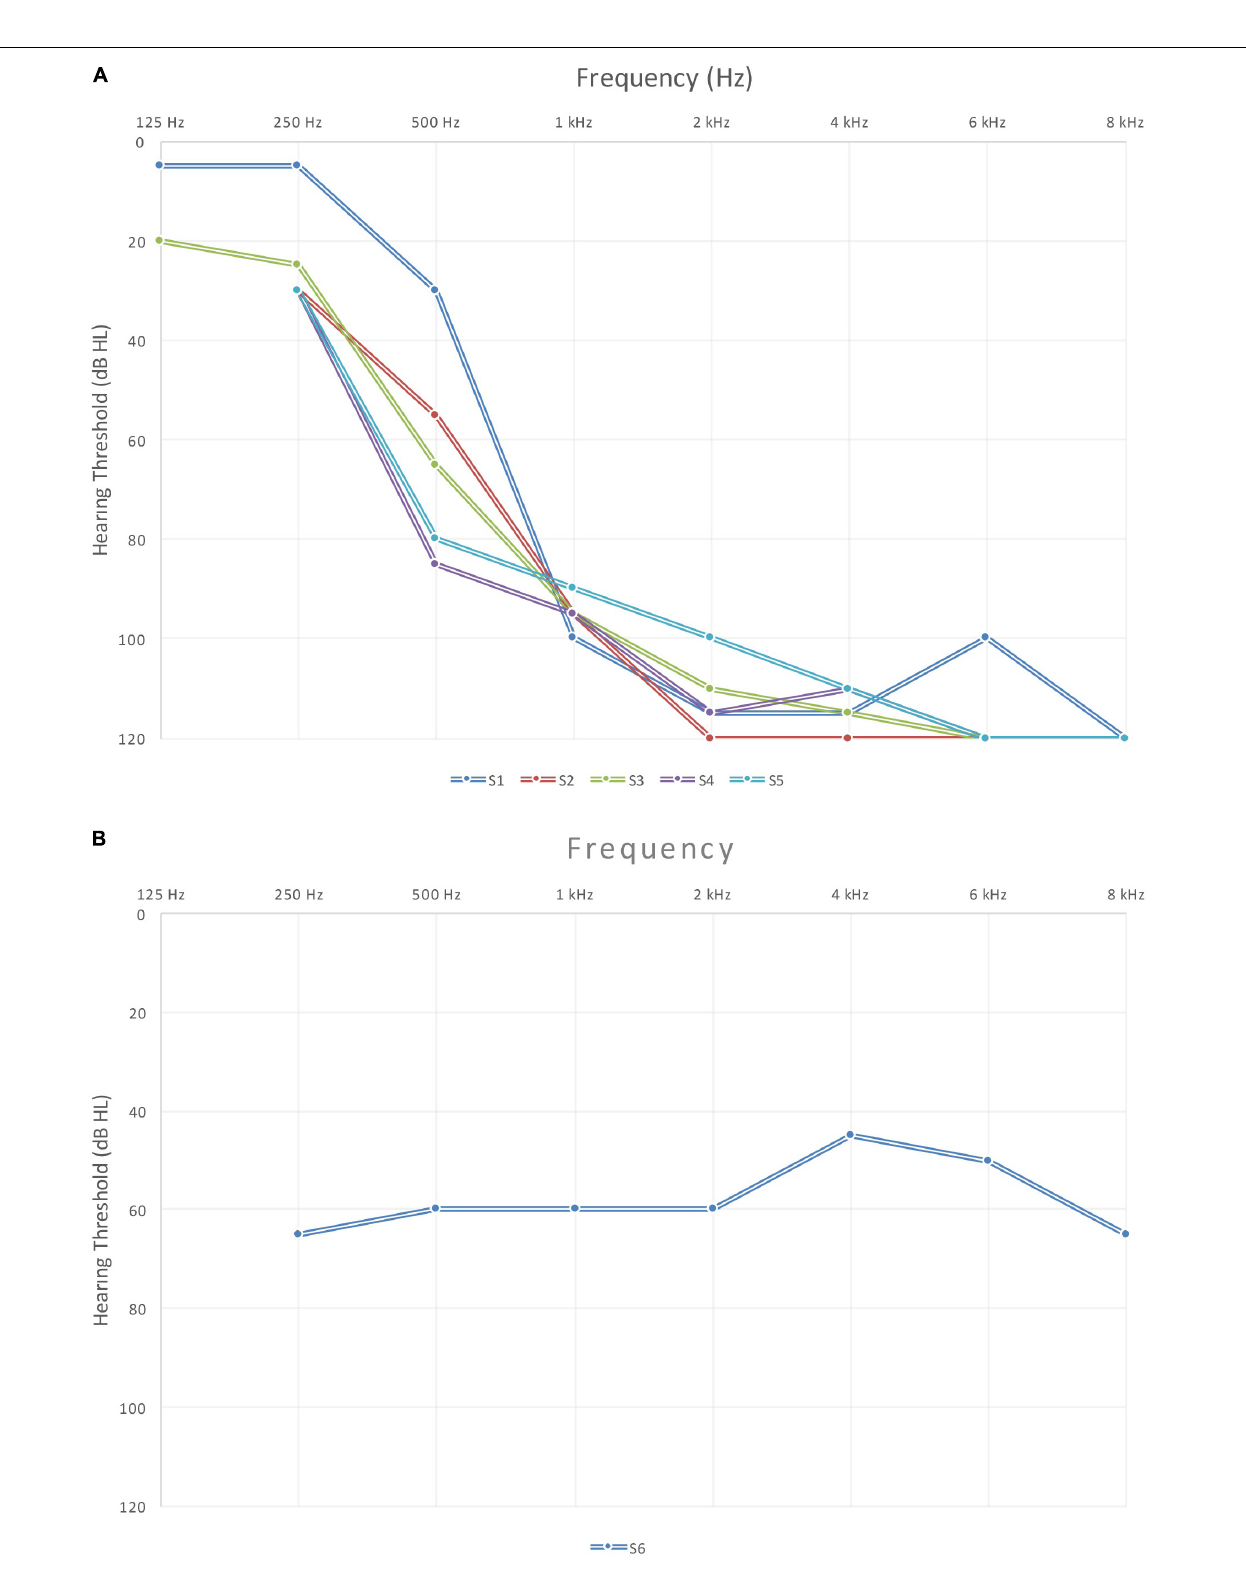
FIGURE 1 | Audiometric configuration for unimplanted ears of study subjects: (A) five study subjects and (B) S6 with different configuration.